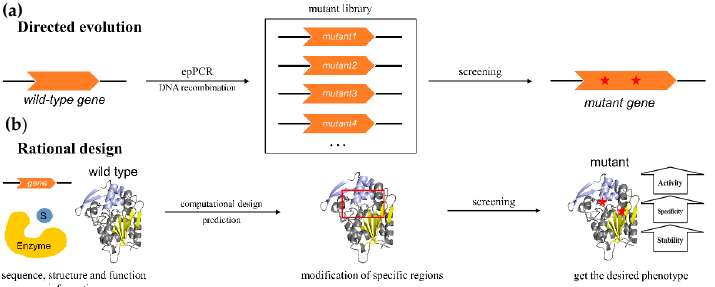
Figure 3. Protein engineering strategies. ( a ) Directed evolution. ( b ) Rational design. “S”, substrate; red stars: mutation sites. The enzyme structure shown in the figure is hydroxynitrile lyase Hb HNL from Hevea brasiliensis (PDB ID: 1YB7) [23].